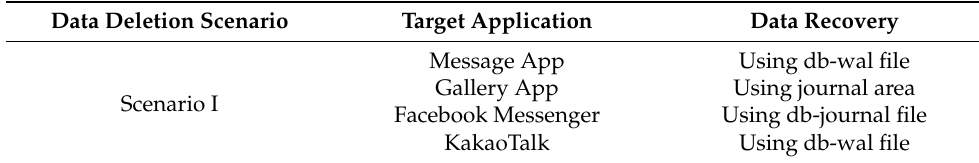
Table 8. Possibility of application data recovery according to data deletion